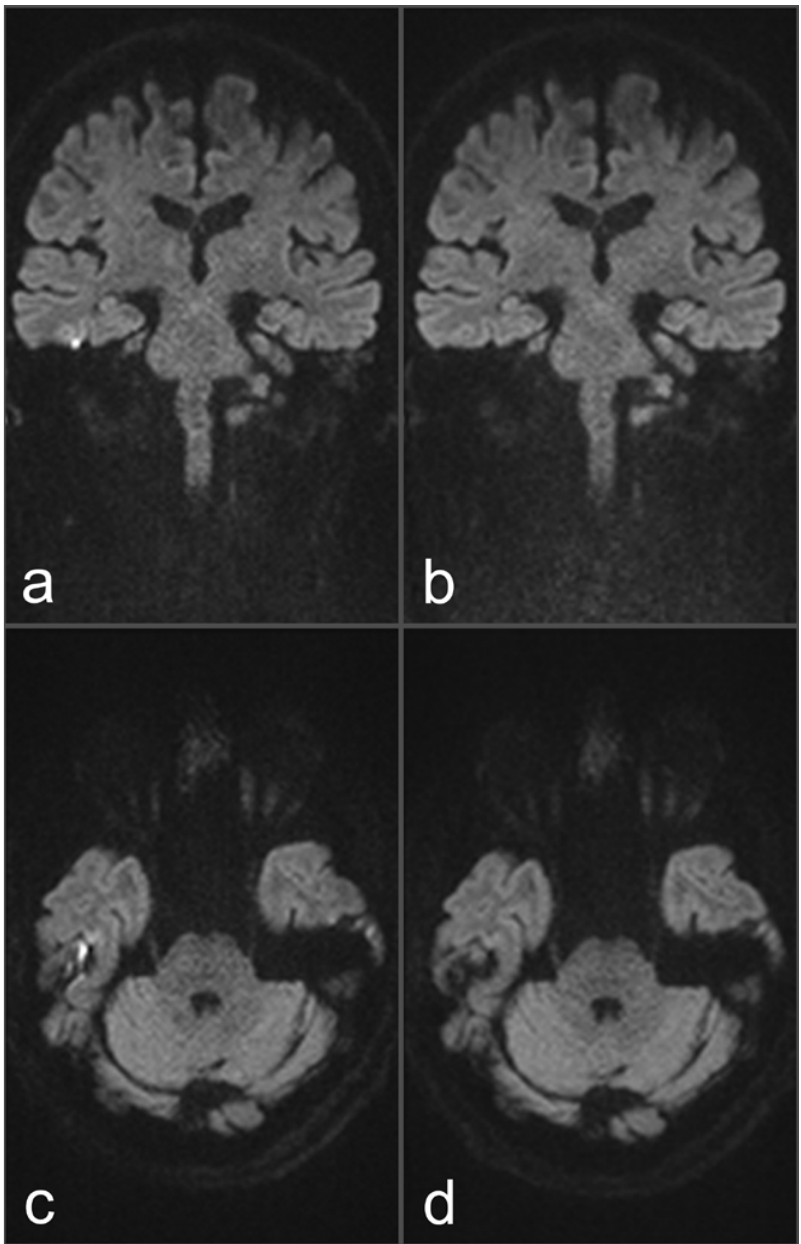
Figure 1. Images of a 34-year-old patient with a suspected cholesteatoma on the right side. ( a ) and ( c ) uncorrected rsDWI (coronal and axial slice orientation). ( b ) and ( d ) topup-corrected rsDWI (coronal and axial slice orientation). Field inhomogeneities at the height of the upper temporal bone generate a brightly appearing lesion in the uncorrected rsDWI images which might be mistaken for a cholesteatoma lesion. Notably, the lesion shows a geometrical distortion on axial slice orientation, whereas a rounded appearance could be identified on coronal image. After topup-correction, the brightly appearing lesion on the right side disappeared completely, unmasking the lesion as an artifact. The “no cholesteatoma” diagnosis was confirmed after surgery with negative histopathological proof.